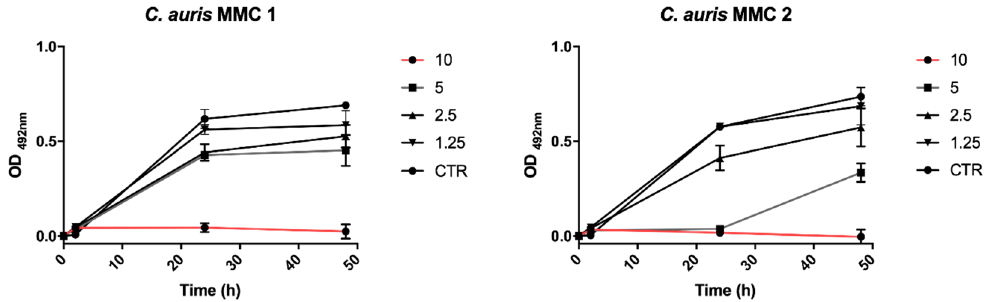
Figure 3. Dose-dependent growth curves were generated for planktonic C. auris MMC 1 and MMC 2 to determine the minimum concentration of NAC-SNO-np to eradicate fungal cells.